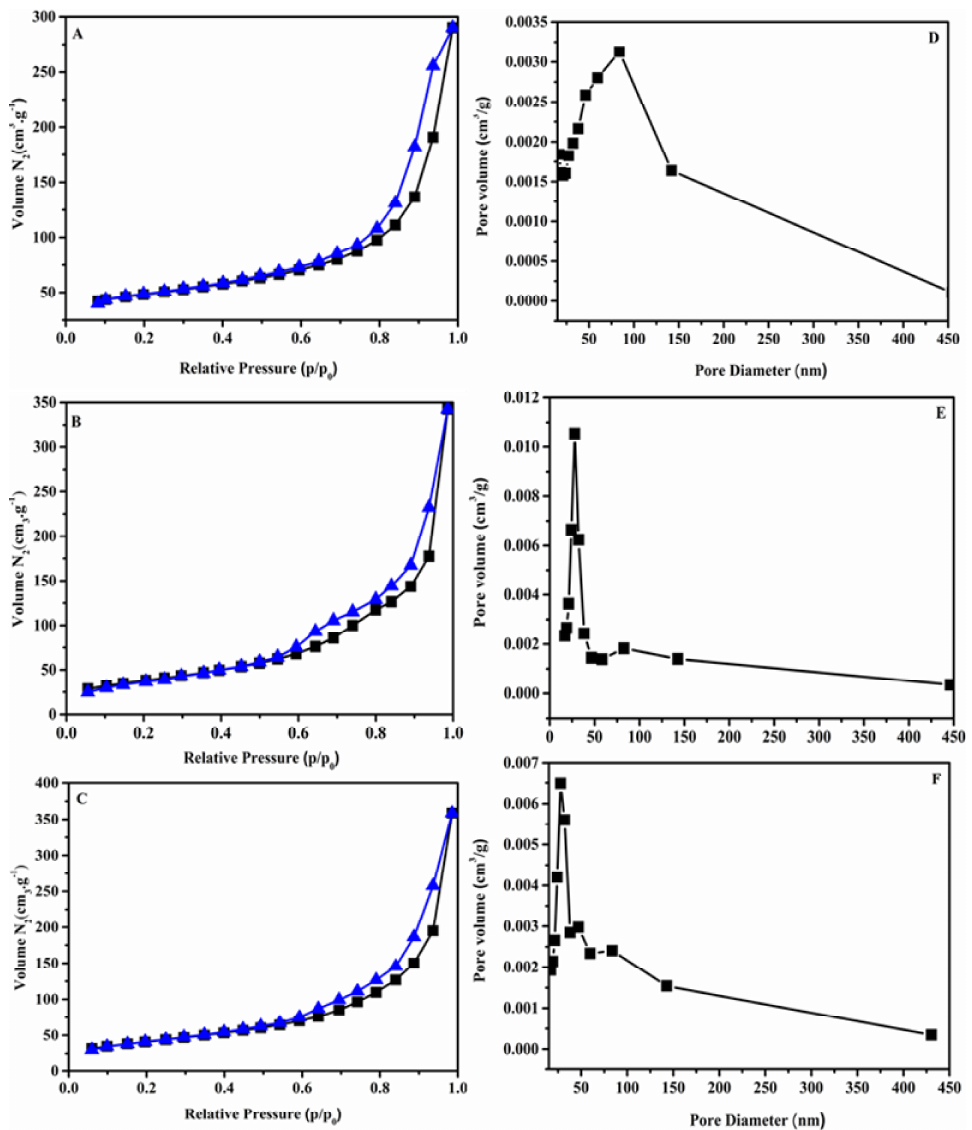
Figure 2. N 2 adsorption–desorption isotherms and pore diameter distribution for: ( A , D ) palygorskite; ( B , E ) TiO2–Pal; and ( C , F ) ZrO 2 -TiO2–Pal. The specific surface area of palygorskite was 113 m 2 g −1 . After TiO 2 deposition on the clay